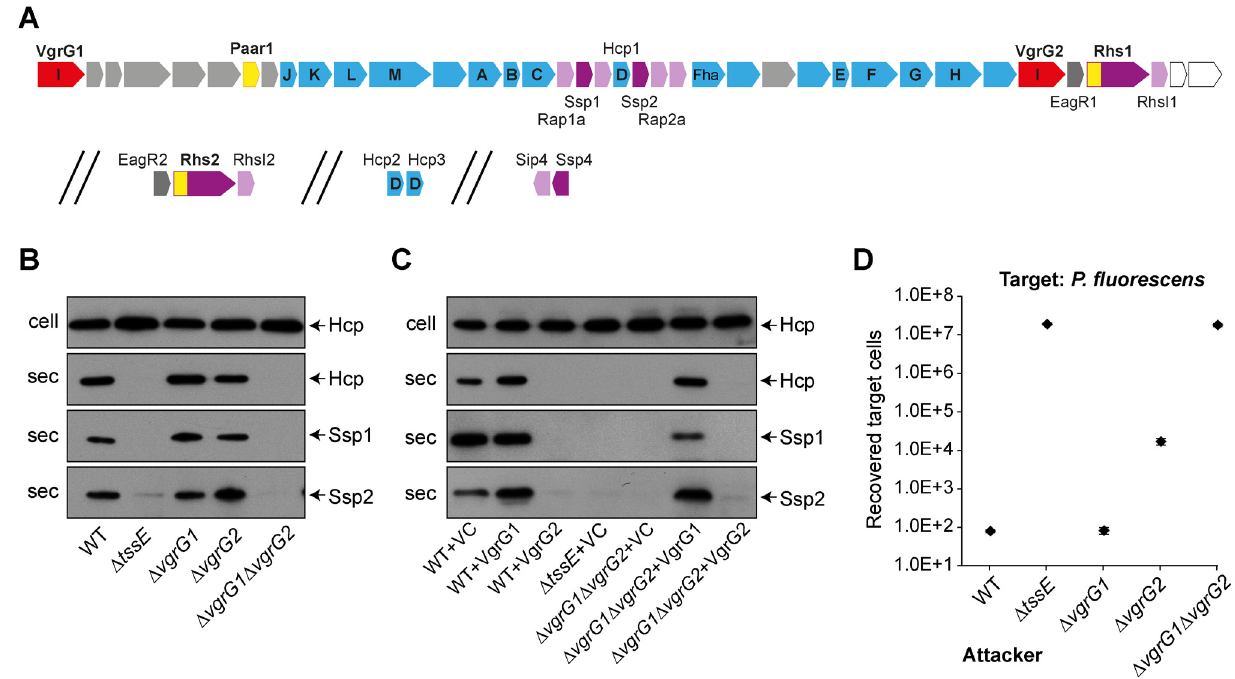
Fig 1. Differential requirement for the two VgrG proteins of Serratia marcescens for Type VI secretion system function and anti- bacterial activity. (A) Schematic depiction of the T6SS genetic loci in S . marcescens Db10 indicating the two VgrG homologues (red), PAAR proteins or PAAR repeat containing domains (yellow), effectors (violet), immunity proteins (pink) and other conserved T6SS components (blue; core TssA-TssM components are indicated by letter). (B) Immunoblot detection of Hcp1, Ssp1 and Ssp2 in cellular and secreted fractions of wild type (WT) or mutant ( Δ tssE , Δ vgrG1 , Δ vgrG2 and Δ vgrG1 Δ vgrG2 ) strains of S . marcescens Db10. The Δ tssE mutant has an inactive T6SS. (C) Immunoblot detection of secreted proteins in wild type or mutant strains carrying either the vector control plasmid (+VC, pSUPROM) or plasmids directing expression of VgrG1 (+VgrG1, pSC622) or VgrG2 (+VgrG2, pSC623) in trans . (D) Number of recovered cells of P . fluorescens 55 following co-culture with wild type or mutant strains of S . marcescens Db10 as attacker. Points show mean +/- SEM (n =